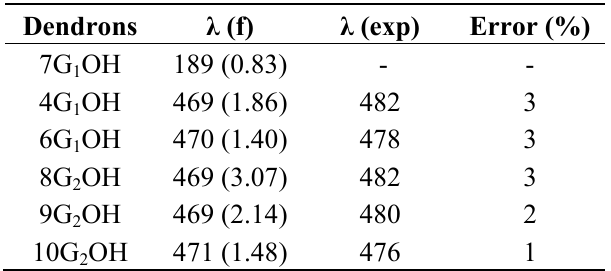
in nm obtained at M062x/LANL2DZ level in chloroform are Table 2. UV-vis λ max reported. Oscillator strengths (f) in parenthesis are